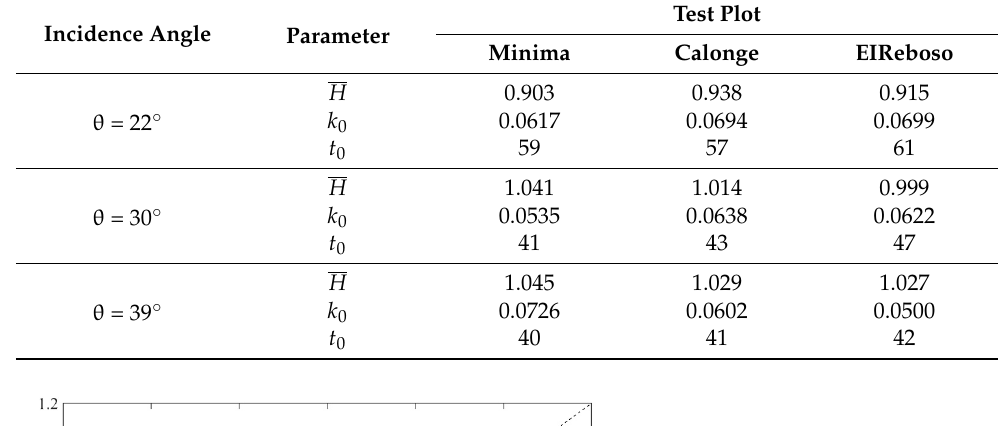
Table 4. Average values of the estimated growth parameters corresponding to the different test plots. Incidence Angle Parameter